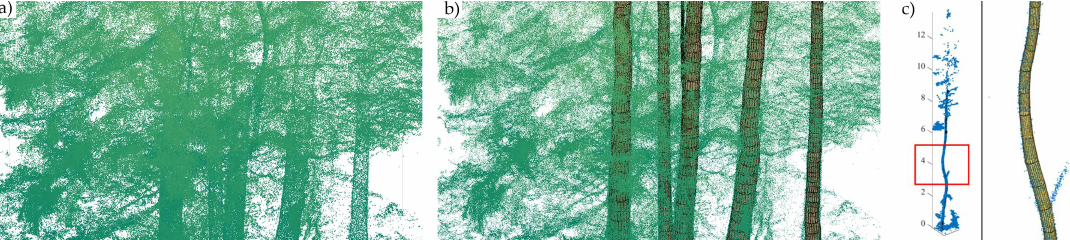
Figure 13. ( a ) Point cloud of a proportion of the forest; ( b ) A visualization of the corresponding reconstructed stems in ( a ); ( c ) An example tree shows that our method is able to handle the curvature of the deformed